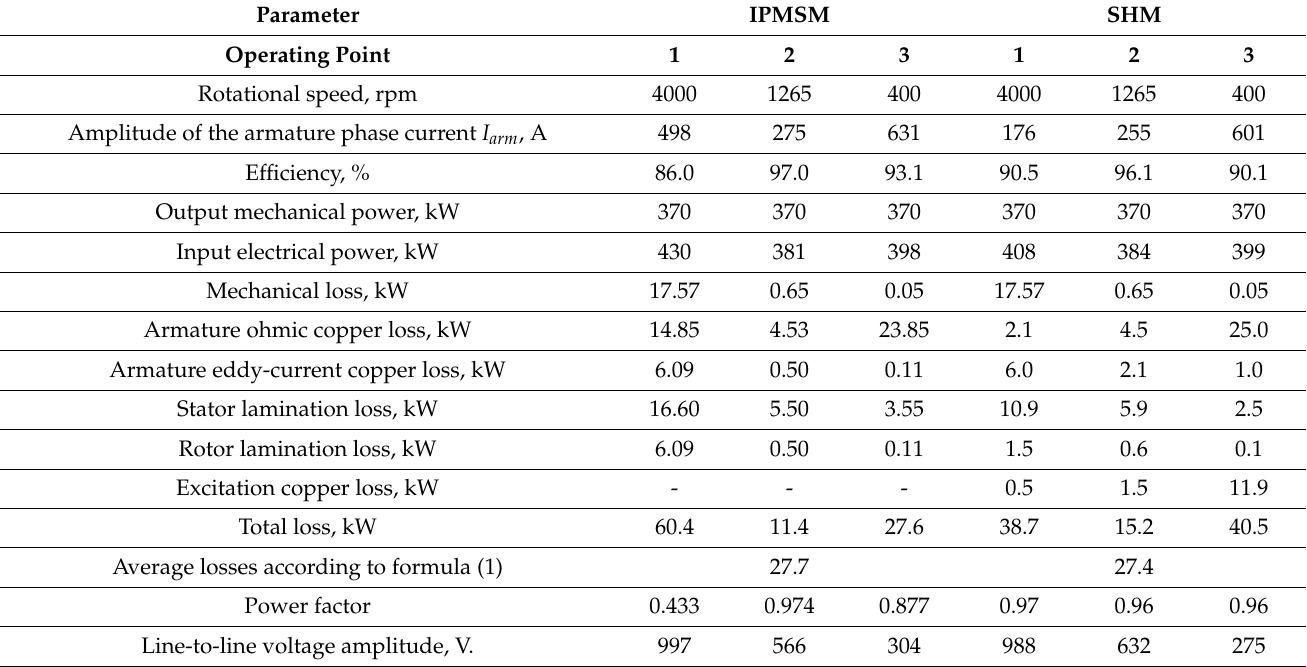
Table 5. Performance comparison of IPMSM and SHM after the